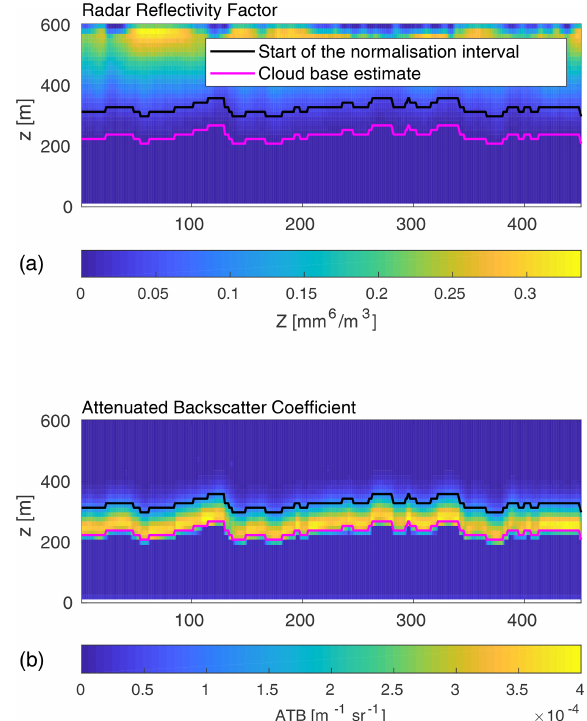
Figure 1. Cross section of the radar reflectivity factor (a) and atten- uated backscatter coefficient (b) of the cloud scene produced with the ECSIM simulator. The magenta line indicates the estimate of the cloud base height, and the black line indicates the beginning of the normalisation